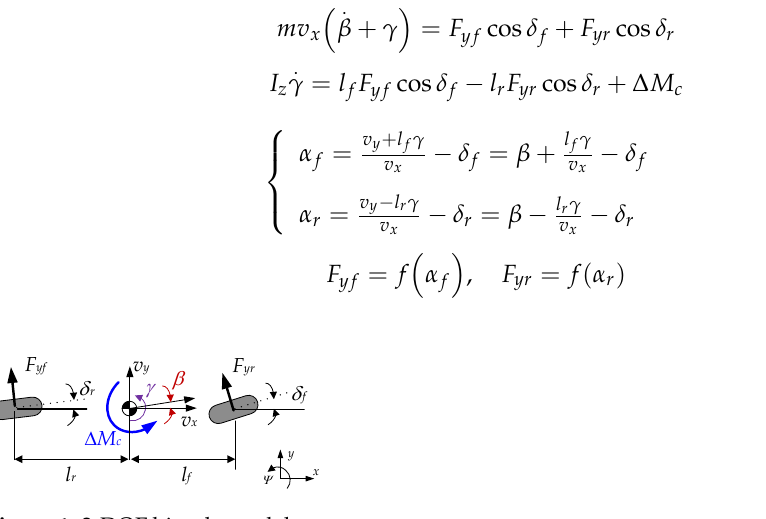
Figure 1. 2-DOF bicycle model.